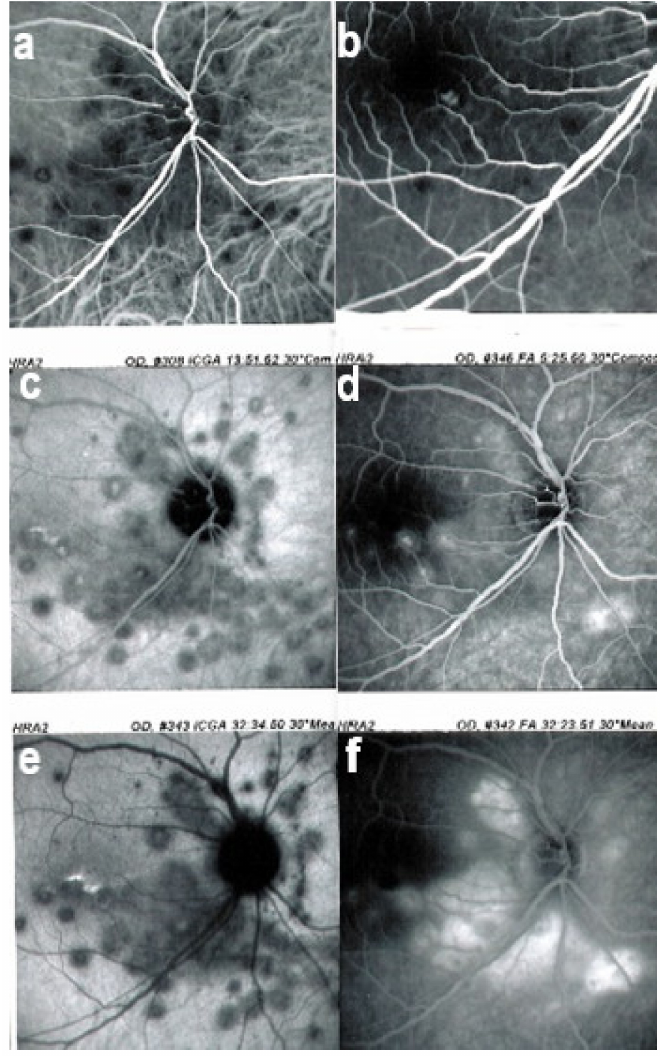
Figure 16. MFC. Parallel time sequence of ICGA ( a , c , e ) and FA ( b , d , f ) during recurrence. Top pair ( a , b ) show early ICGA and FA frames, showing extended hypofluorescent area on ICGA, while FA is practically normal. Middle pair ( c , d ) of images show intermediate phase of ICGA and FA (about 10 min) with more extended and well-visible zones of hypofluorescent choriocapillaris nonperfusion on ICGA, while FA shows leakage and staining. Bottom images ( e , f ) corresponding to late ICGA hypofluorescent areas causing retinal ischaemia and reactional retinal vessel hyperpermeability following the same mechanism as in